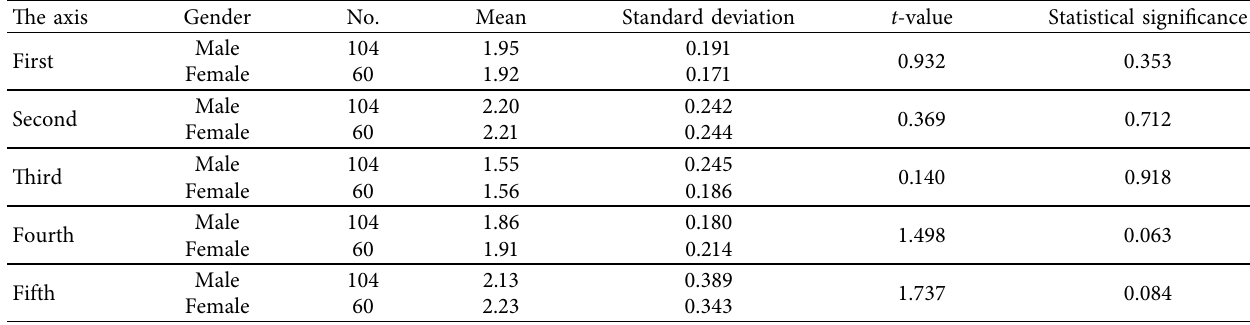
Table 11: Results of a t -test for a comparison between the averages of responses to the questionnaire on the reality of the use of MTM by the staff at the UOH by